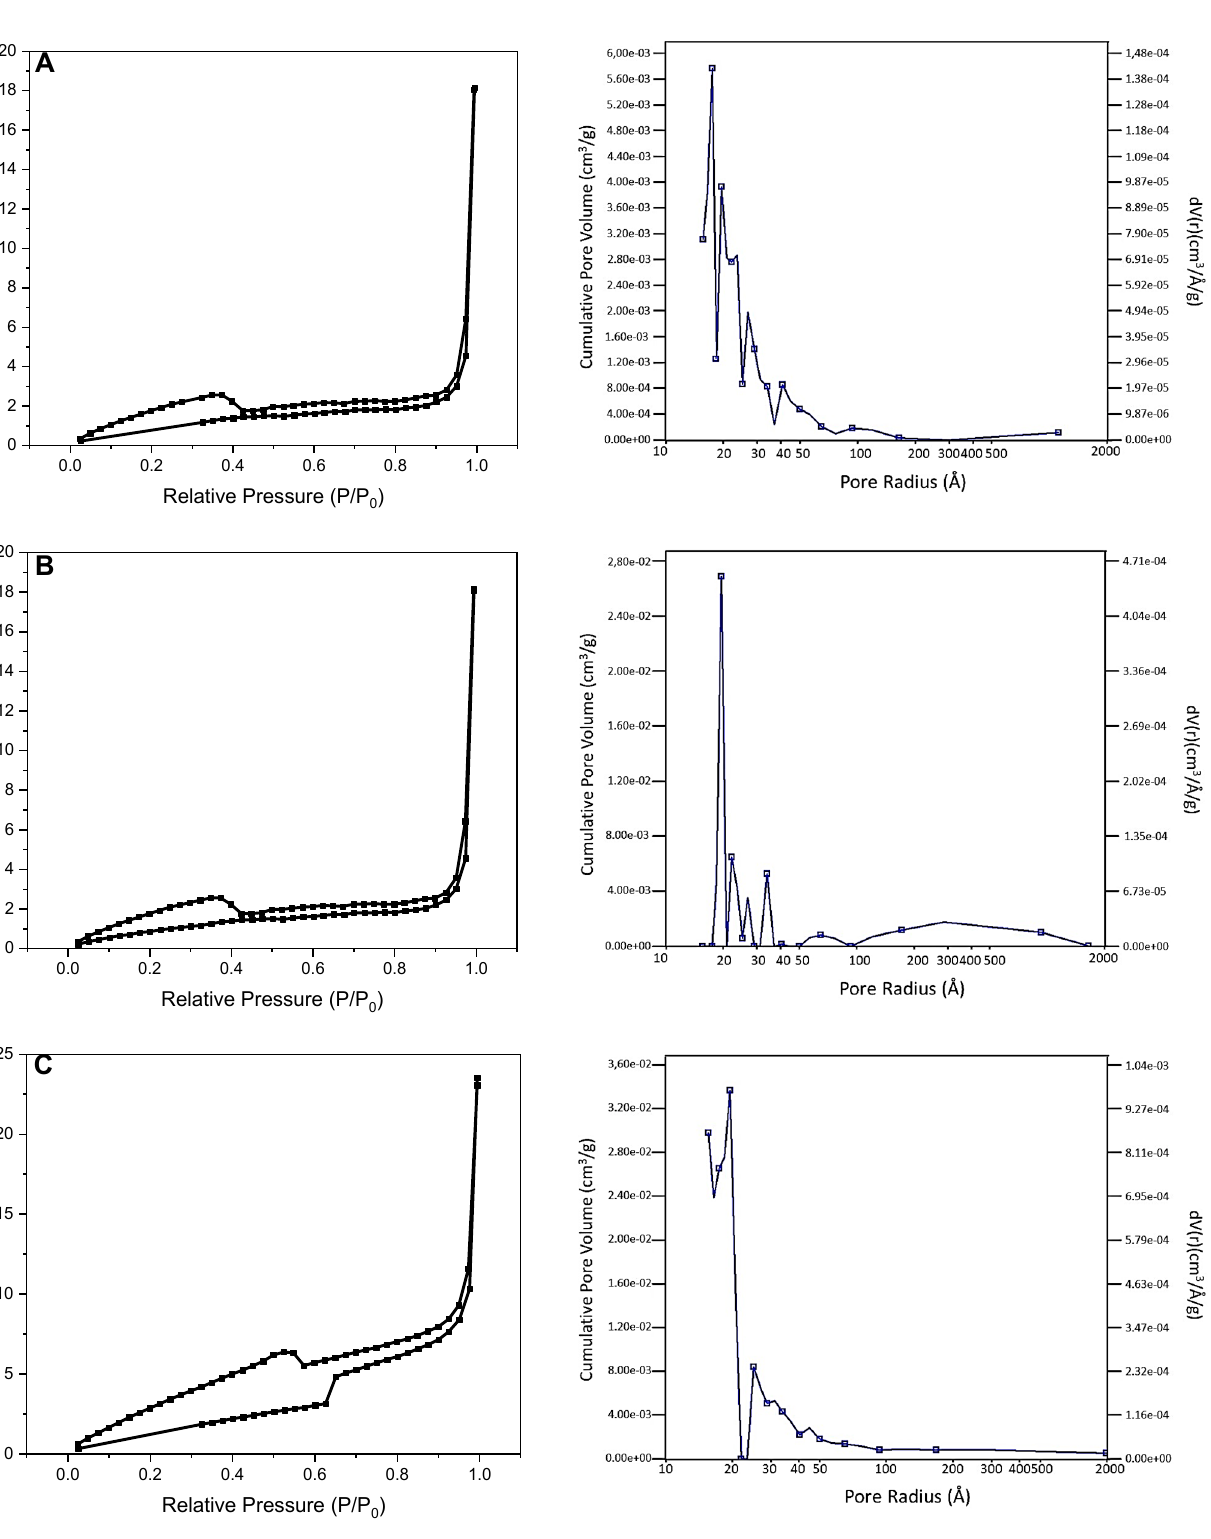
Figure 1. Isothermal data (left) and pore size distributions (right) of catalyst material: ( A ) pristine, ( B ) after fourth cycle, and ( C ) after fourth cycle and thermic treatment at 400 ◦